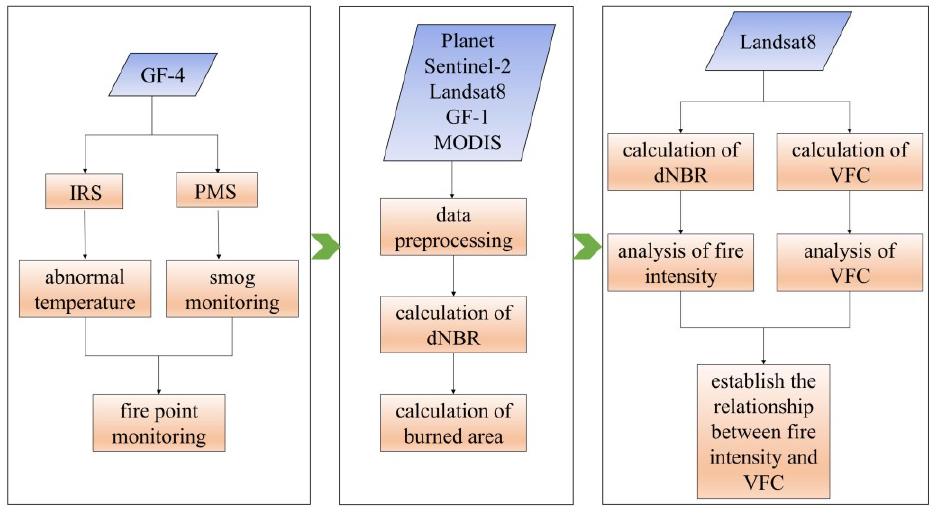
Figure 2. Flow chart of forest fire monitoring with multi-source remote sensing data.